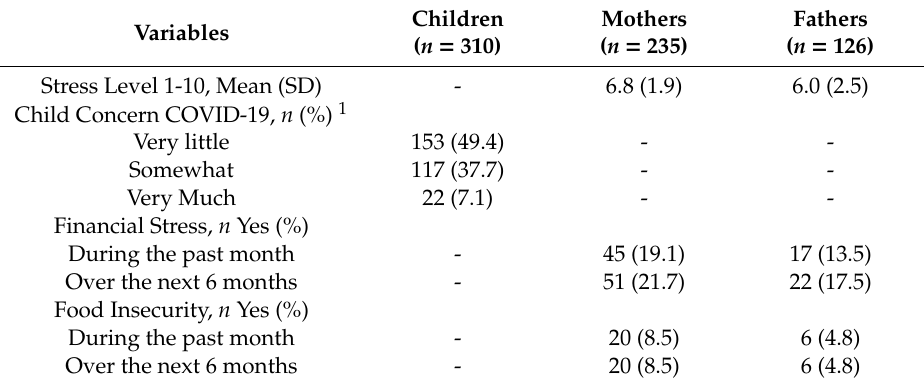
Table 2. Reported stress, financial, and food security among families ( n = 254).